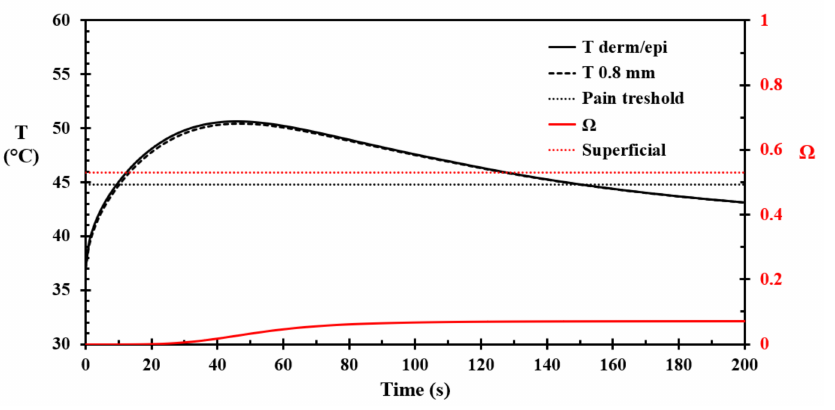
Figure 8. The basal layer and 0.8 mm depth skin temperature, and the corresponding damage integral development, versus time for Case 3, i.e., 3.16 kW/m 2 as the flare heat flux to the most exposed point at the